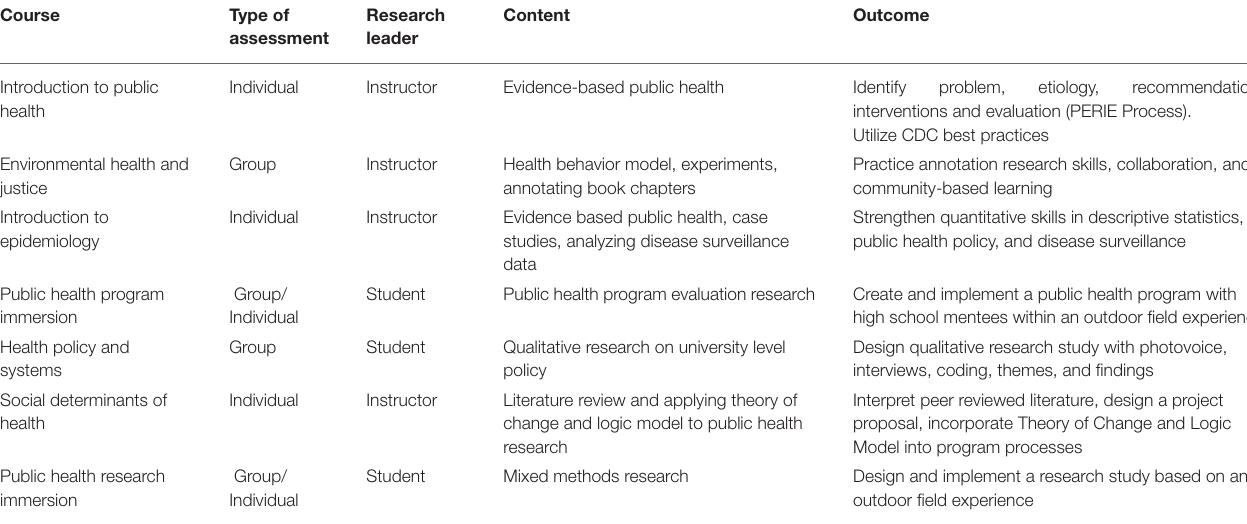
TABLE 3 | Public health course research